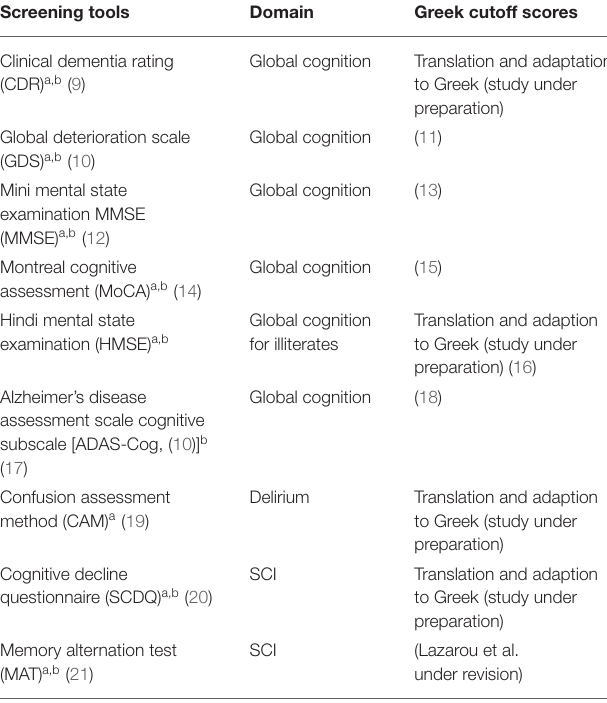
TABLE 2 | Further neuropsychological